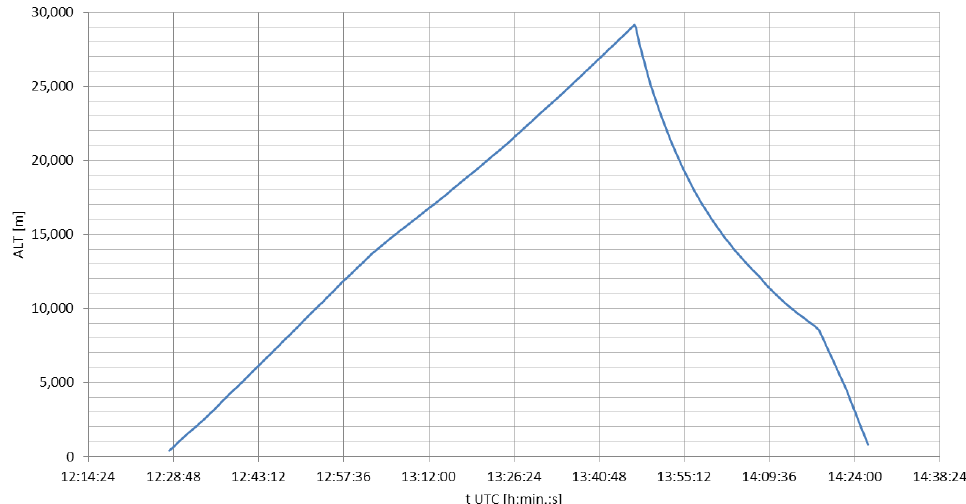
Figure 7. The altitude profile of the experimental fully airborne VLF light-balloon mission from 12